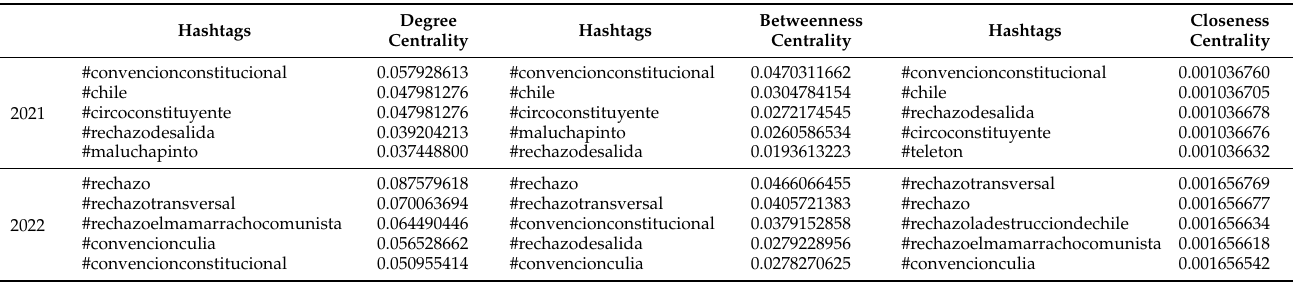
Table 4. Five highest hashtags in local network metrics for “Lista del